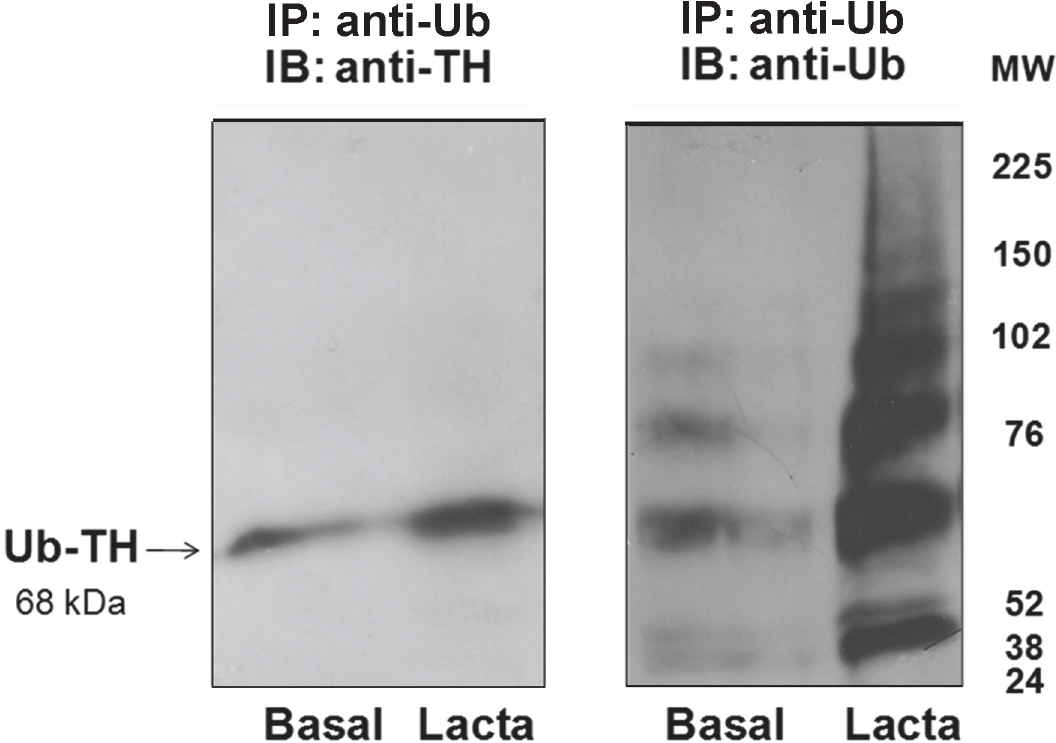
Fig 2. TH ubiquitination. PC12 cells were incubated for 30 min in the absence (basal) or presence of lactacystin (Lacta) (1 μ mol/L). Ub-TH was immunoprecipitated with an ubiquitinated protein enrichment kit (IP: anti-Ub). Proteins were resolved in a 4 – 12% SDS-PAGE and Ub-TH protein level assessed by Western-blot as described under Methods. The same membrane was stripped and reprobed with an antibody against ubiquitin (Ub) to further corroborate that Ub-proteins were isolated with the kit. Three separate experiments were performed. A representative Western blot immunoblotted with antibodies directed against TH or Ub is